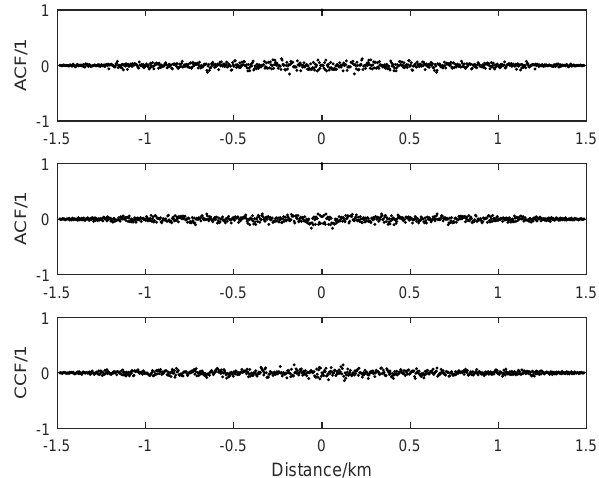
Figure 6. Properties of the transformed residual deviations shown in Fig. 5: (top) auto-correlation function for the transformed residual deviations at the off-resonant wavelength, (middle) auto-correlation function for the transformed residual deviations at the on-resonant wavelength, and (bottom) cross-correlation function for the two sets of transformed residual